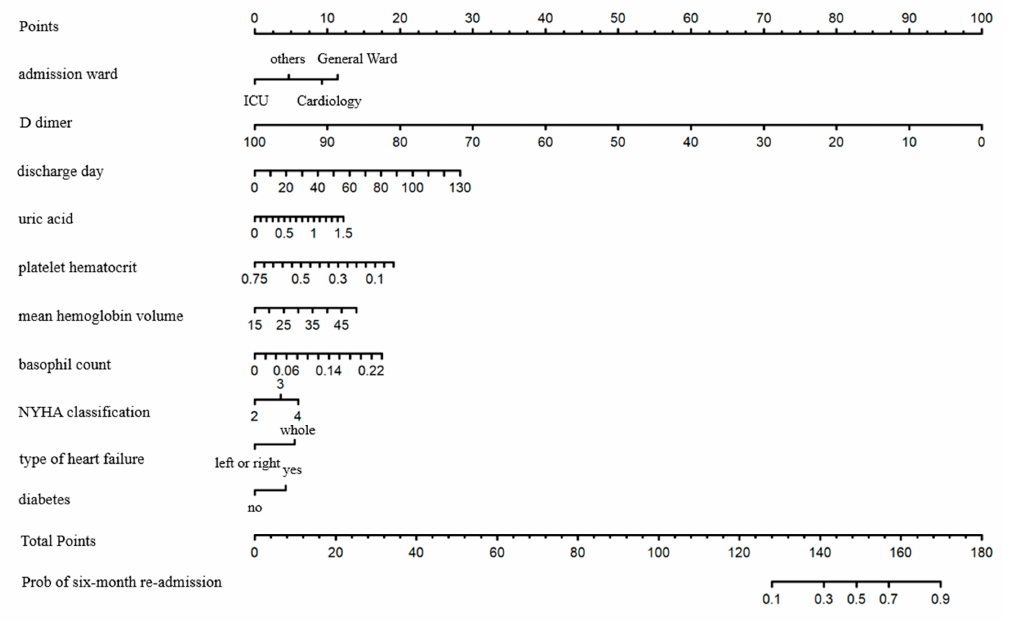
Figure 4. The nomogram of the logistic regression model. NYHA classification: New York Heart classification; ICU: intensive care unit. Points can calculate individual scores for each of the patient’s variables, and the total score is the result of adding the individual scores for each variable. Based on the total score, the probability of all-cause re-admission can be determined.